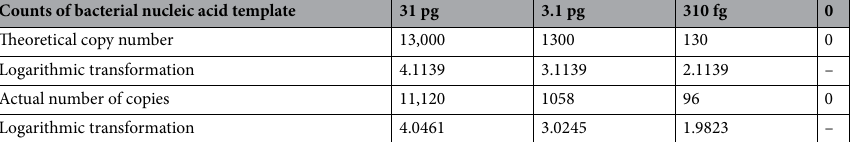
Counts of bacterial nucleic acid template 31